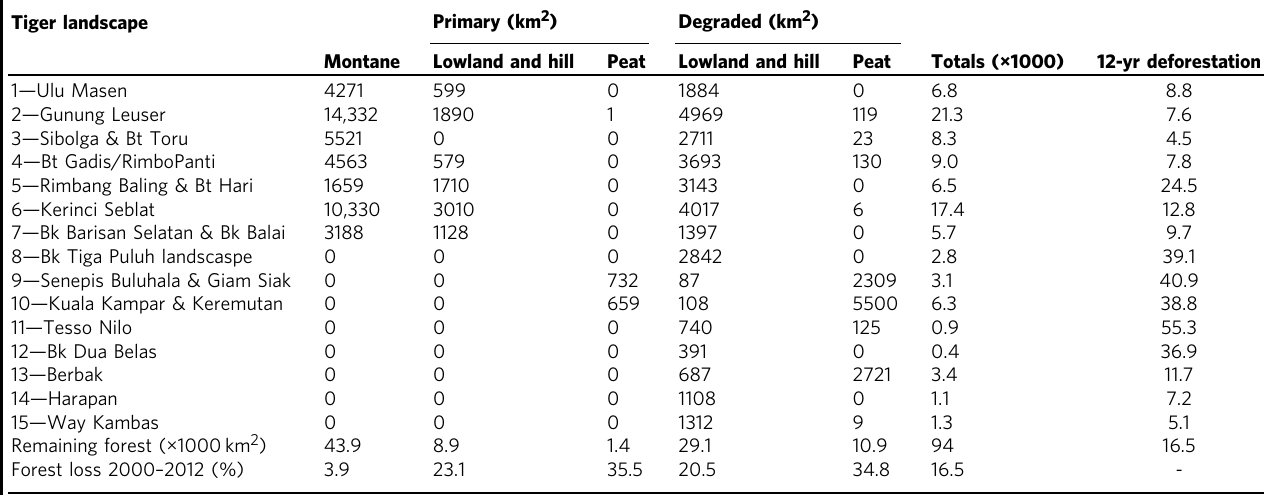
Table 2 Forest cover in Sumatran tiger landscapes 2000 – 2012